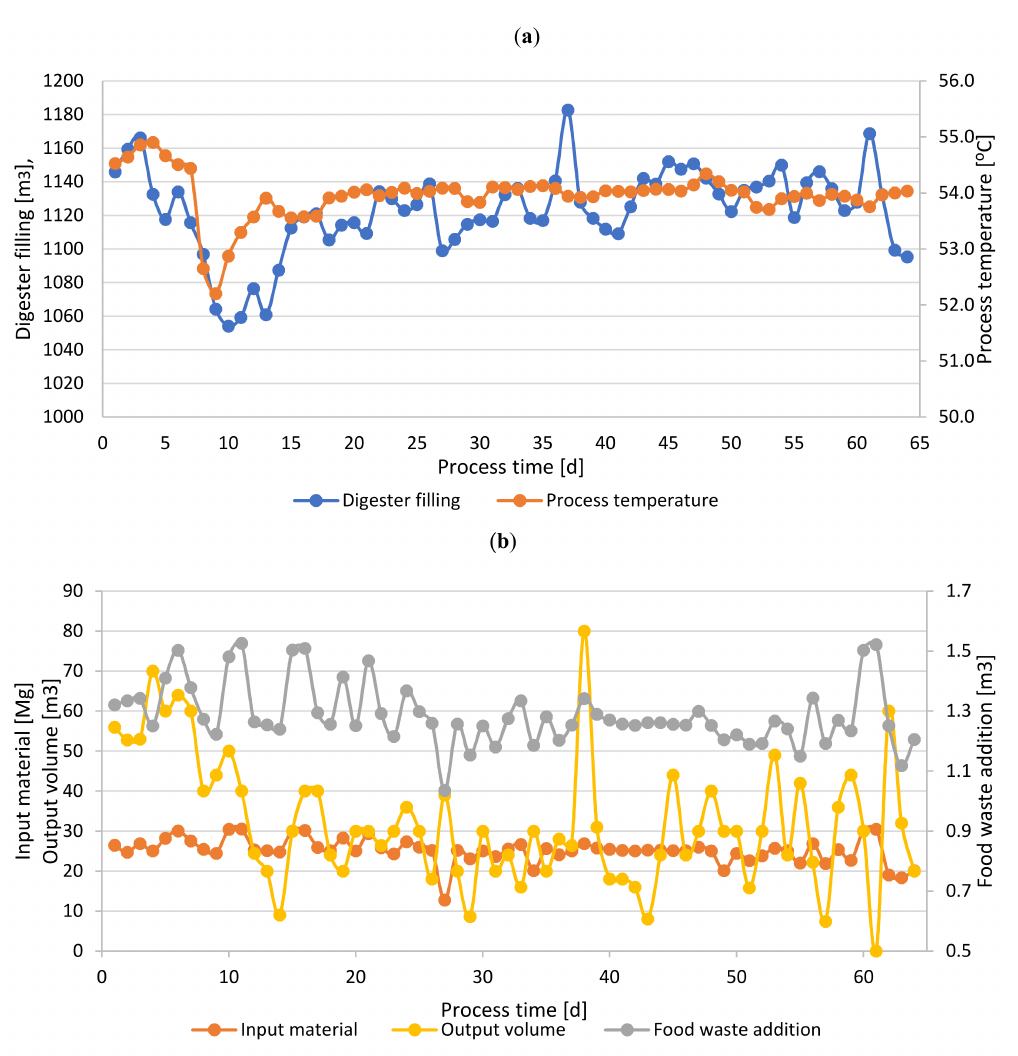
Figure 2. Changes of the anaerobic digestion parameters: ( a ) digester filling and process temperature and ( b ) material flow: Input, output, and food waste